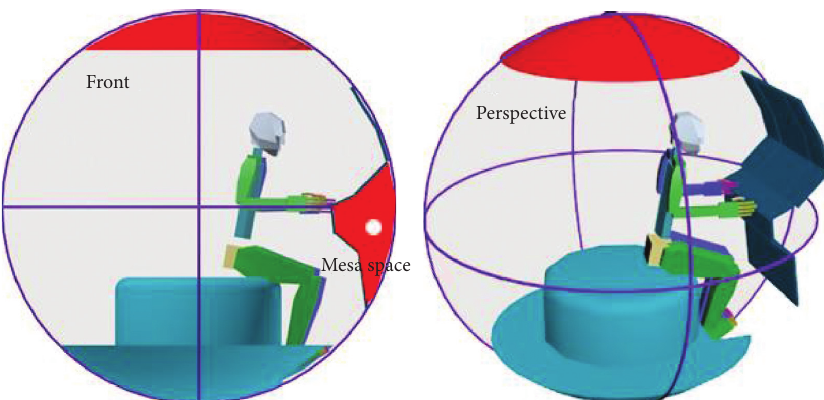
Figure 4: Reconstruction and optimization of the seat for three submersible pilots.